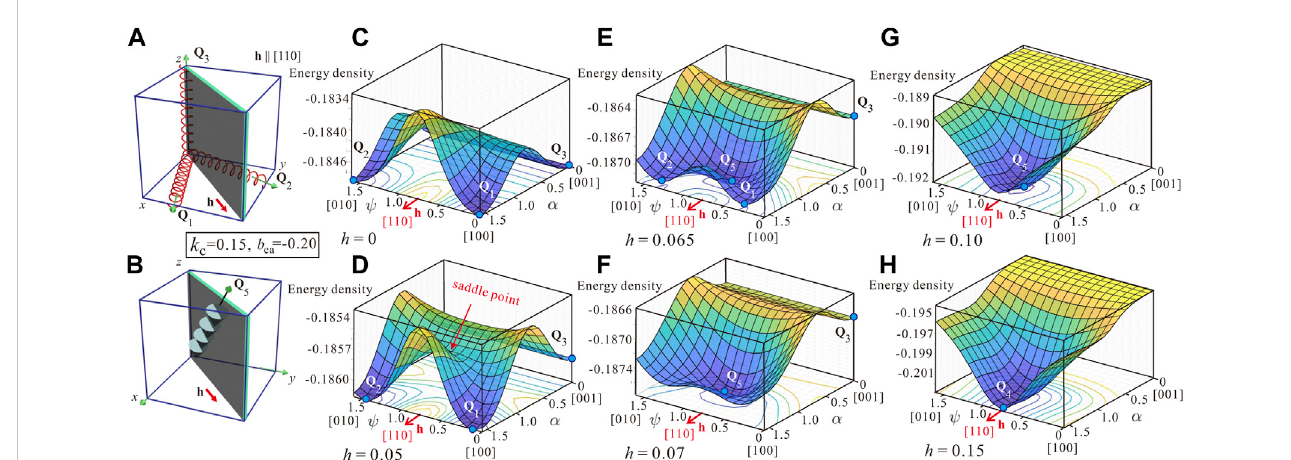
FIGURE 5 (coloronline)Spiralreorientation forH (cid:1) [110]and k c =0.15, b ea = − 0.20. (A) Thethreespiralstatesinlowmagnetic fi elds.Underanappliedmagnetic fi eld, the oblique spiral states with Q 1 and Q 2 (along the [100] and [010] directions in zero fi eld, respectively) undergo a fi rst-order phase transition into the tilted spiral state with the wave vector Q 5 composing some angle with respect to the fi eld (B) , whereas the metastable transversal spiral with the wave vector Q 3 (cid:1) [001] persists up to a higher magnetic fi eld. With the increasing magnetic fi eld, the tilted spiral aligns with the [110] direction. Such a spiral reorientation, which is different from the case considered in Figure 4, is characterized by the surface plots of the energy density (C – H) plotted for several fi eld values and allowing to capture the subtleties of the described